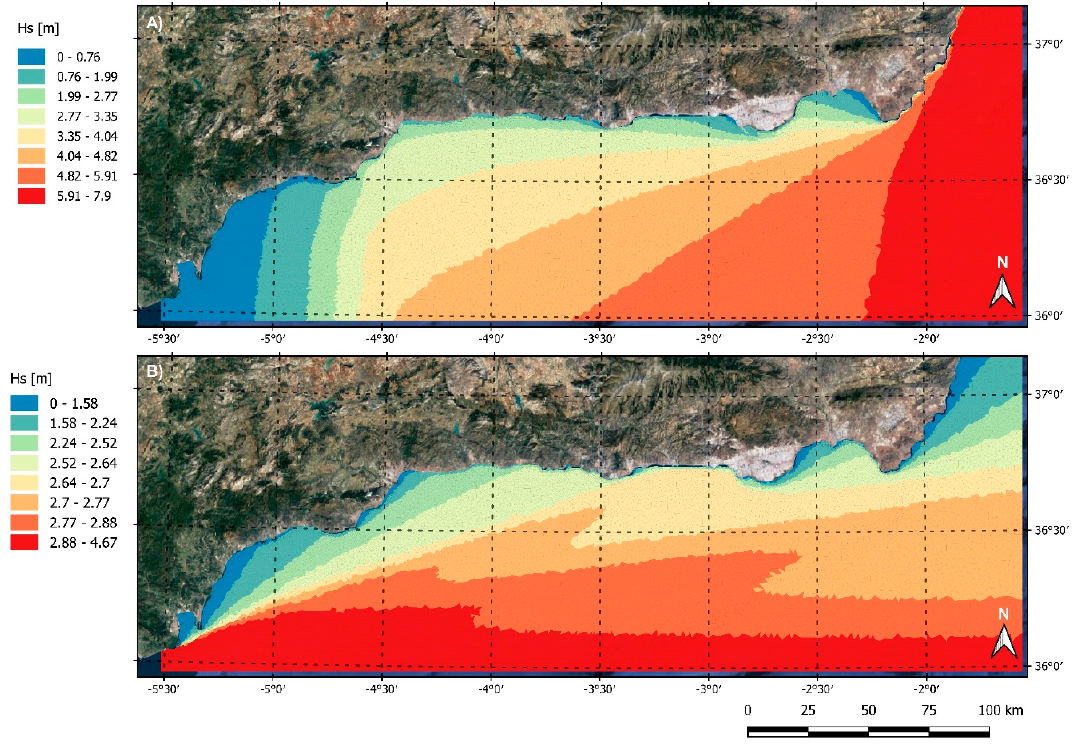
Figure 4. Significant wave height obtained by the numerical model run. ( A ) Offshore boundary conditions: mean wave direction = 67.5° ENE and wave height return period = 50 years. ( B ) Mean wave direction = 247.5° ENE and wave height return period = 50 years. Wave height values were divided into 8 intensity classes using the quantile method.